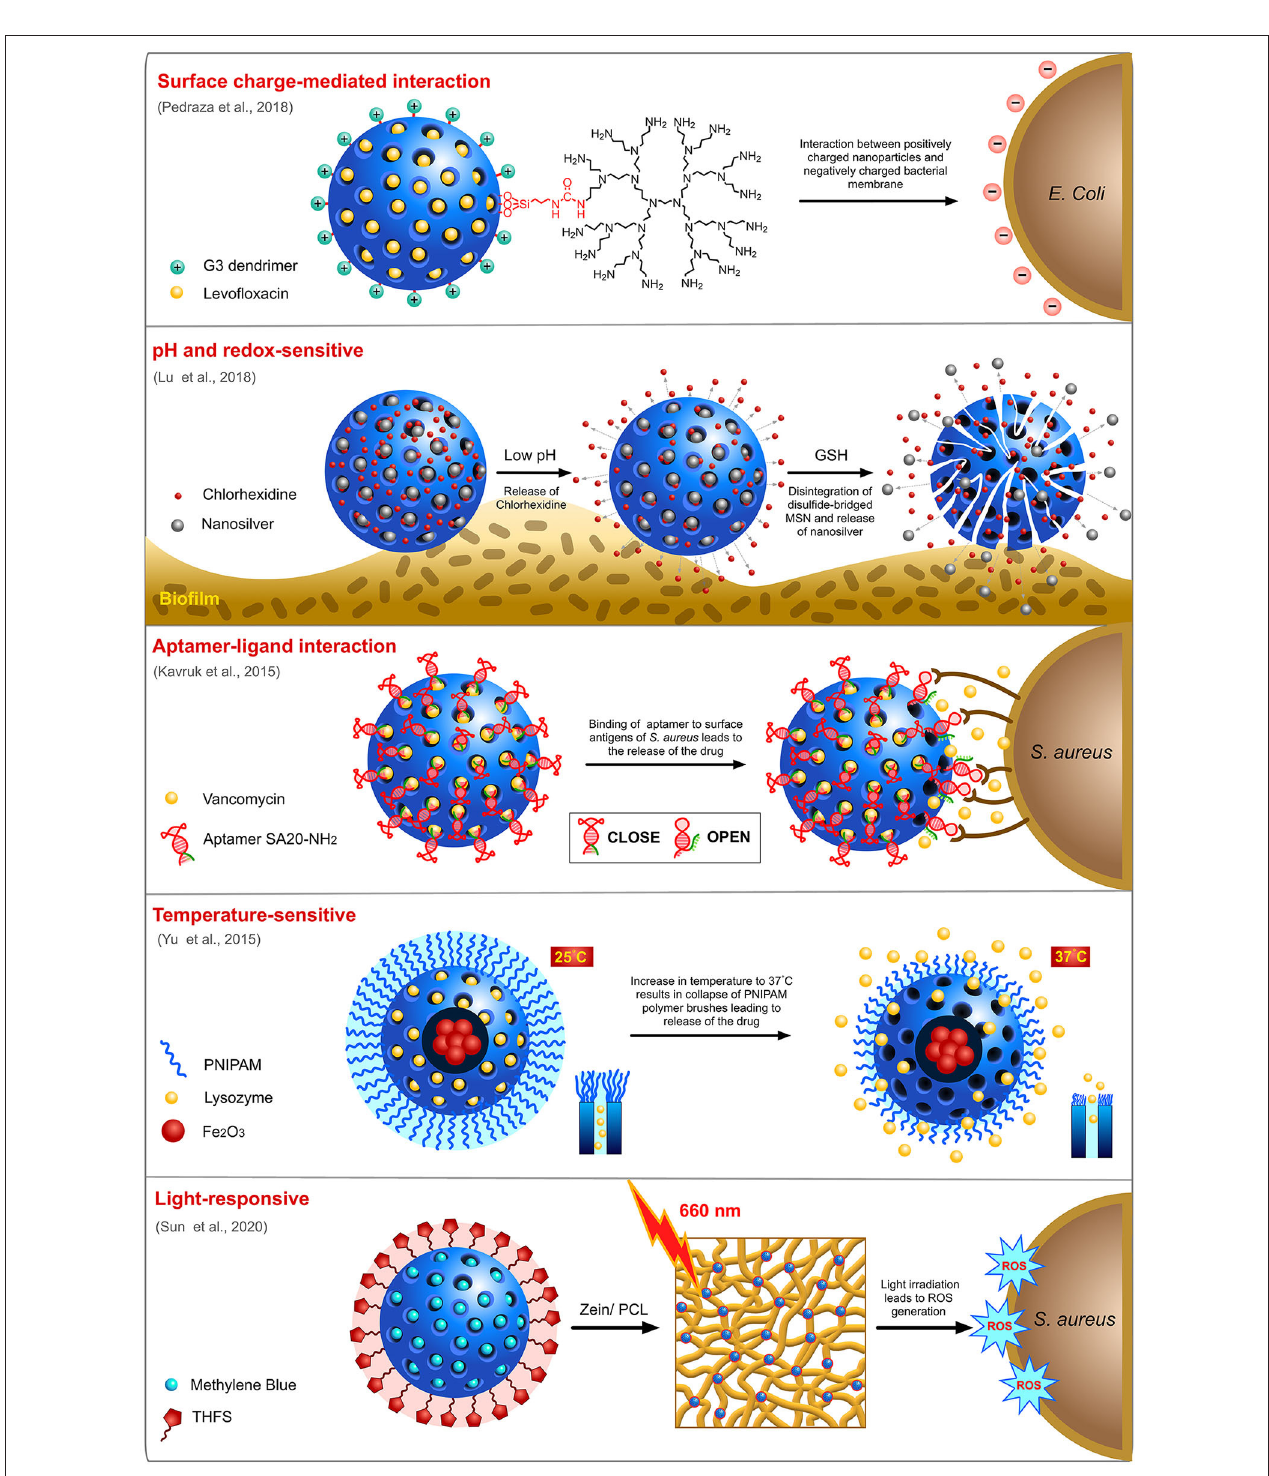
FIGURE 5 | Targeted delivery of antimicrobials by MSN using different strategies.